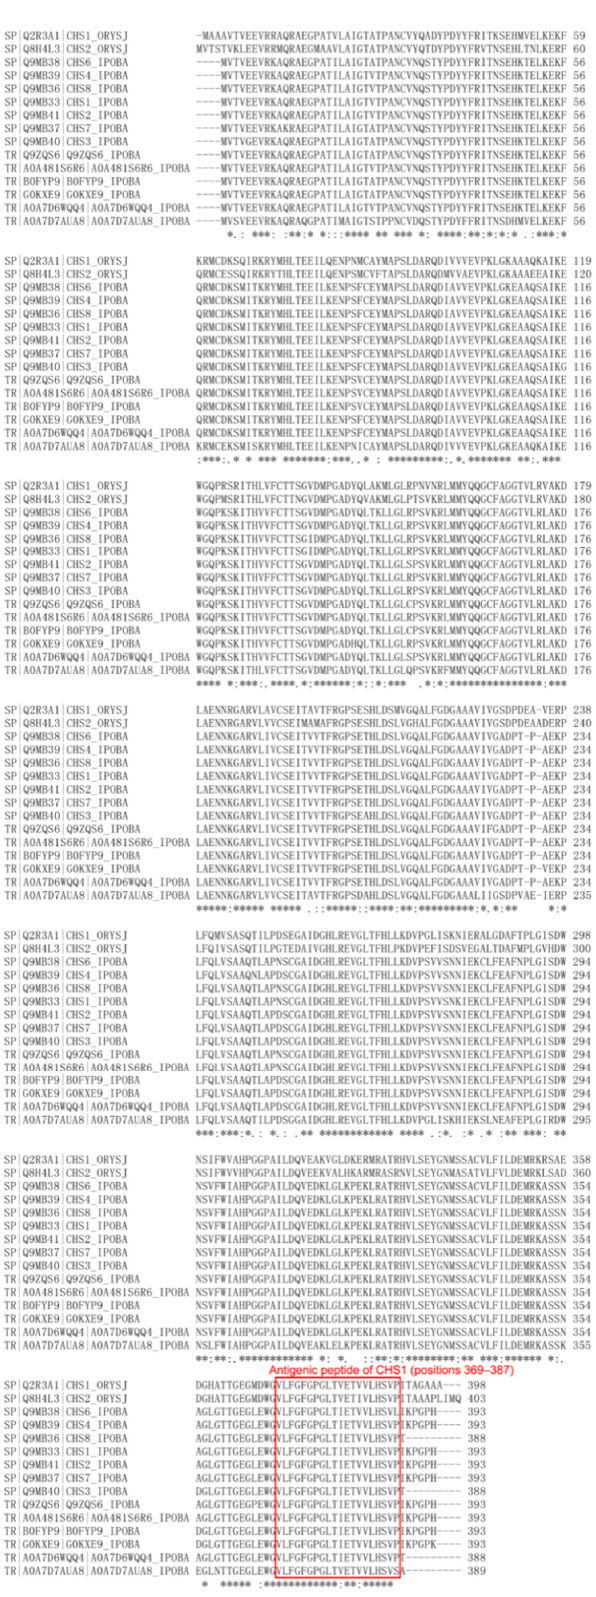
Figure A4. Sequence analysis of CHS. The antigenic peptides of CHS1 are marked with red frames. Align protein sequences with the Clustal Omega program (https://www.uniprot.org/align/, ac- cessed on 25 February 2021) to view their characteristics alongside each other. The asterisks (*) represent significant amino acid residue identity, and the dots (:/.) represent amino acid residue simi-